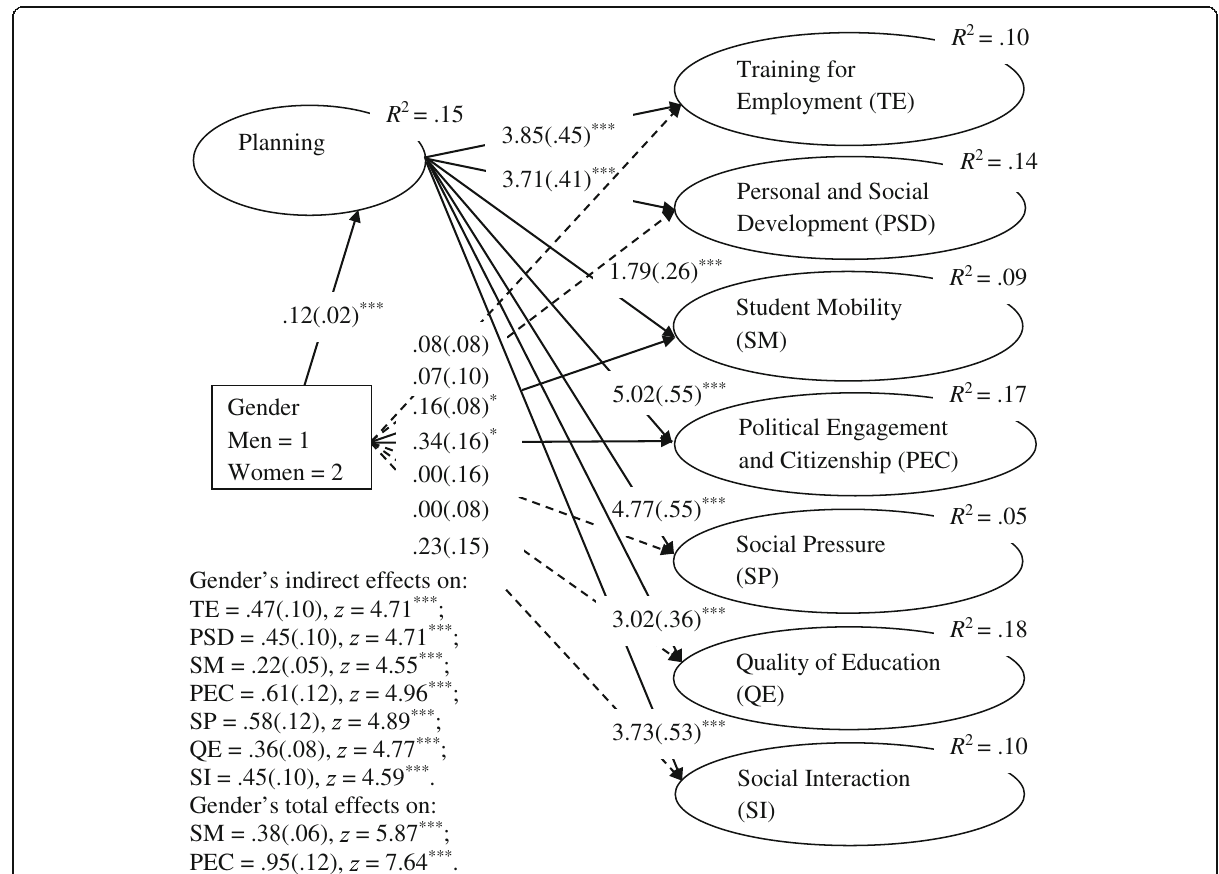
Fig. 2 Model of the planning mediation effect on the predictive relationships between gender and academic expectations. Unstandardized robust maximum likelihood estimates for structural relationships. Standard errors are between parentheses. Dashed arrows = non-significant paths. * p < .05. *** p <